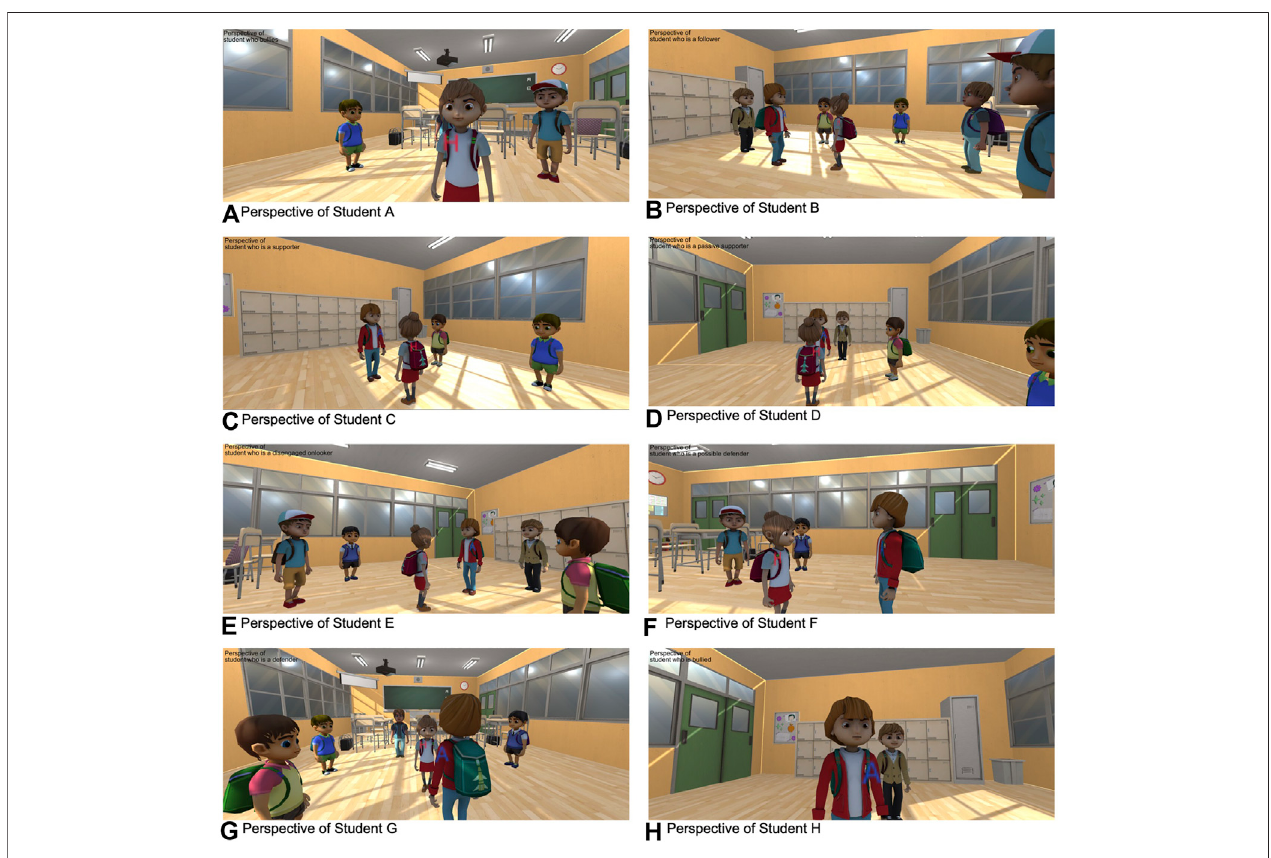
FIGURE 3 | Perspectives of the